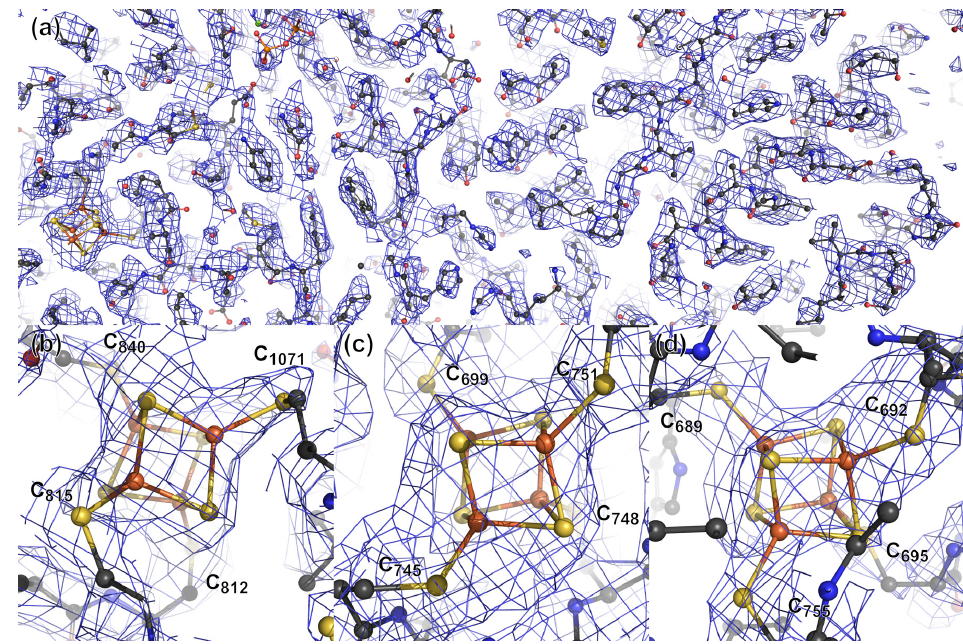
Figure 5. ( a ) View of the quality of the reconstructed cryo-EM density map and the fit of the protein model to it. Close view of the ( b ), proximal ( c ), median and ( d ) distal [Fe 4 S 4 ] clusters of one PFOR monomer. The cryo-EM density mesh is colored blue and contoured at 5 σ.